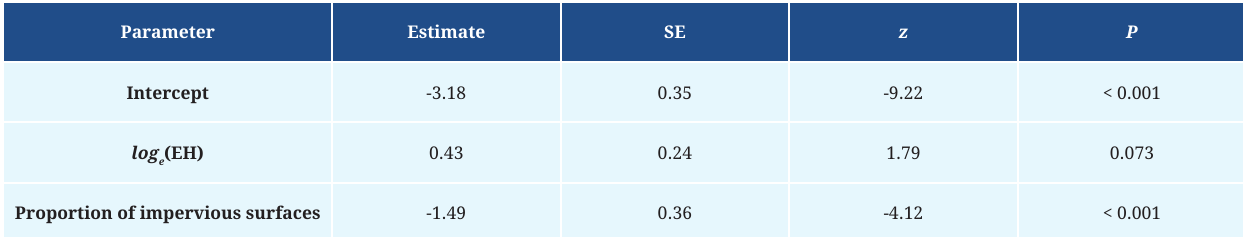
TABLE 2 | Relationship between the local contribution to beta diversity and environmental heterogeneity (EH) and the proportion of impervious surfaces estimated with a beta regression model. EH consists of distances to a median value estimated from environmental data. The proportion of impervious surfaces was a proxy for urbanization. SE: